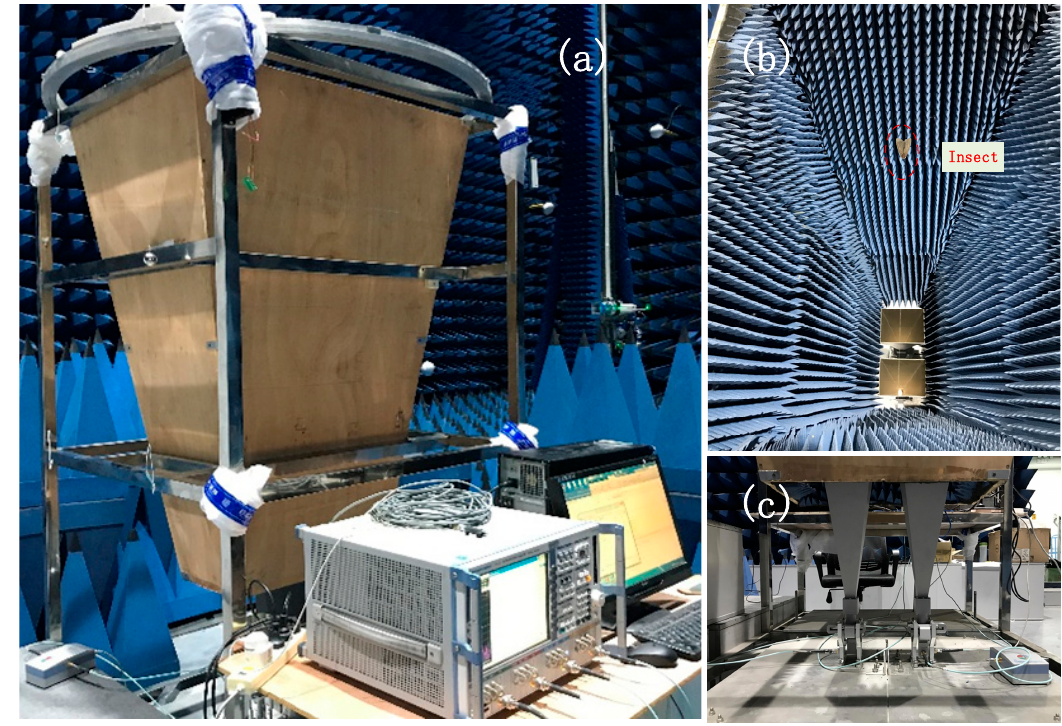
Figure 1. Laboratory equipment for the measurement of insect radar cross section (RCS) parameters in the microwave anechoic chamber. ( a ) Experimental rig; ( b ) experimental insect attached to a short polyethylene line; ( c ) transmitting and receiving dual-polarization antennas working in the X band.